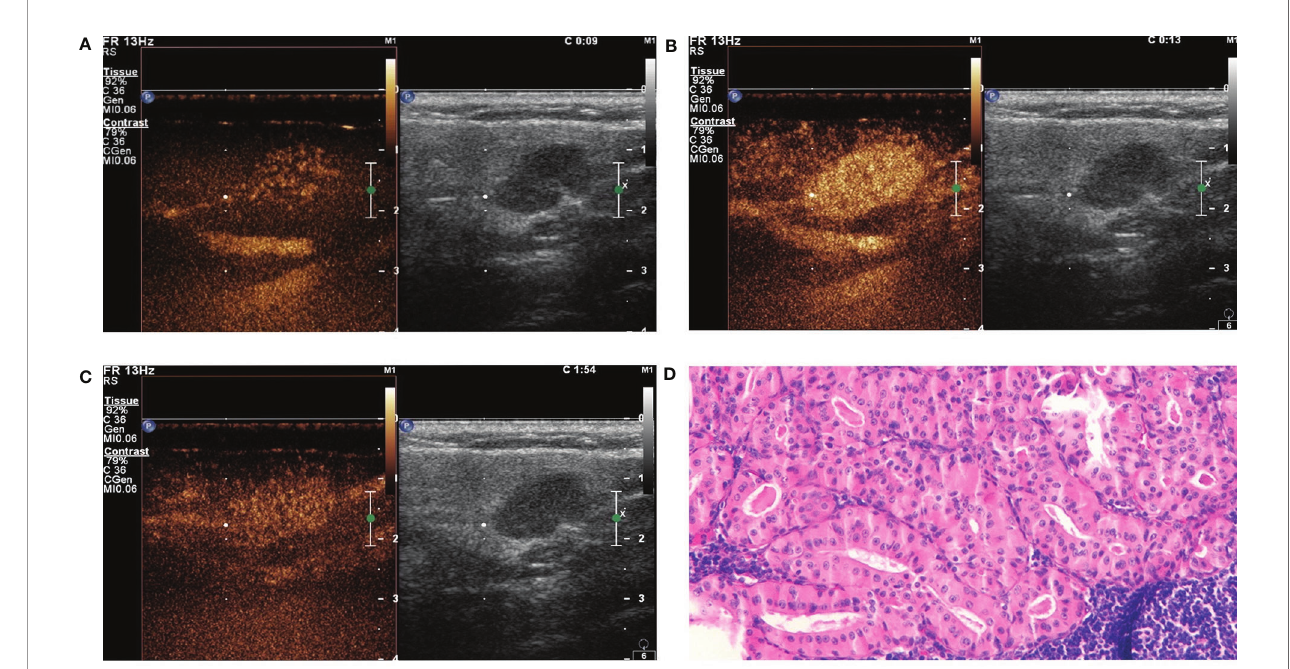
FIGURE 2 | Warthin tumor (WT) in contrast-enhanced ultrasound (CEUS). The qualitative CEUS indicated the mass with highly intensive and homogeneous enhancement and the perfusion pattern of contrast agent was “ fast in and slow out ” ( A -early phase; B -middle phase; C -late phase). (D) H&E stain (original magni fi cation ×100).